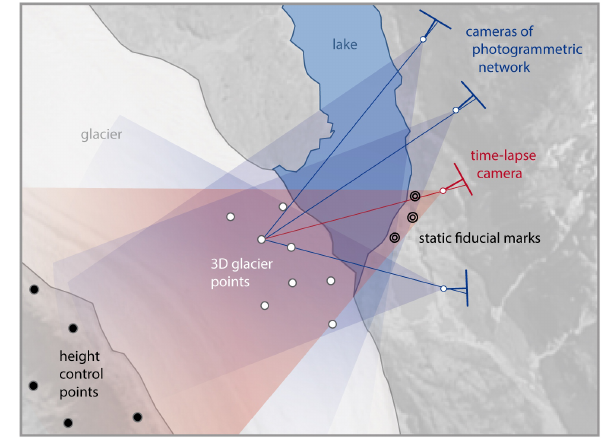
Figure 1. Area of investigation. (Source: Landsat 8 OLI (L1T):18.01.14)